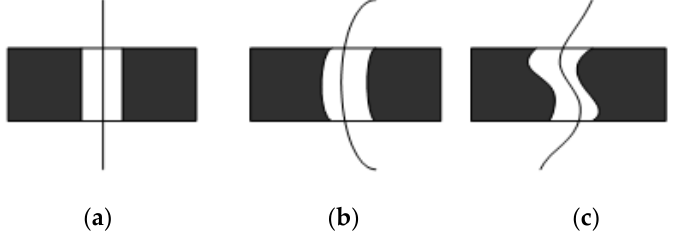
Figure 4. The Influence of Geodesic Curvature on the Consistency of Paint Thickness.